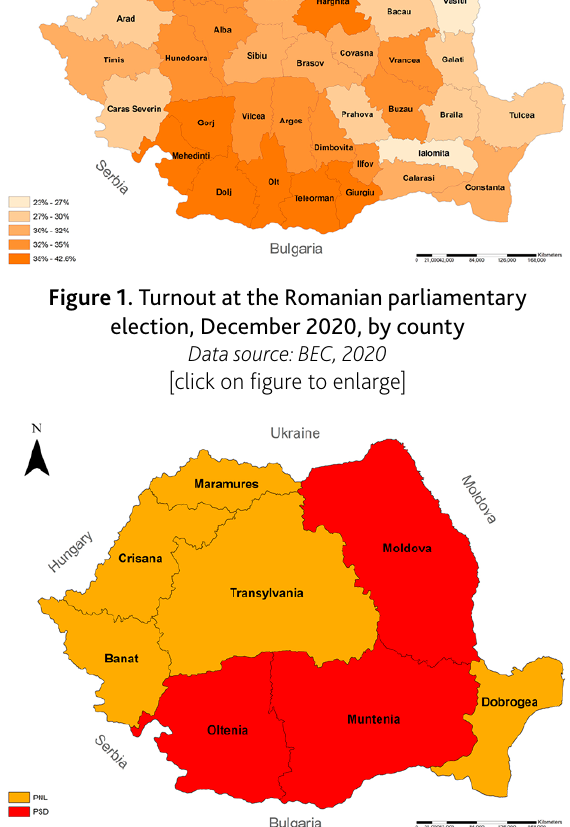
Figure 2. The winning parties in the historical regions of Romania, Romanian parliamentary elections,